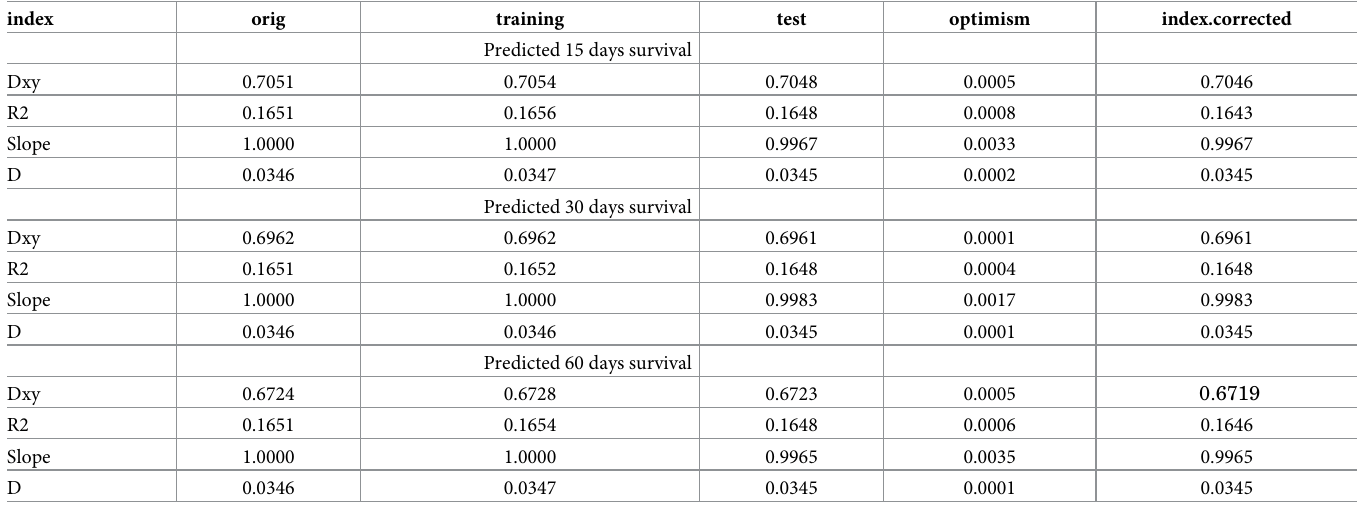
Table 4. Validation